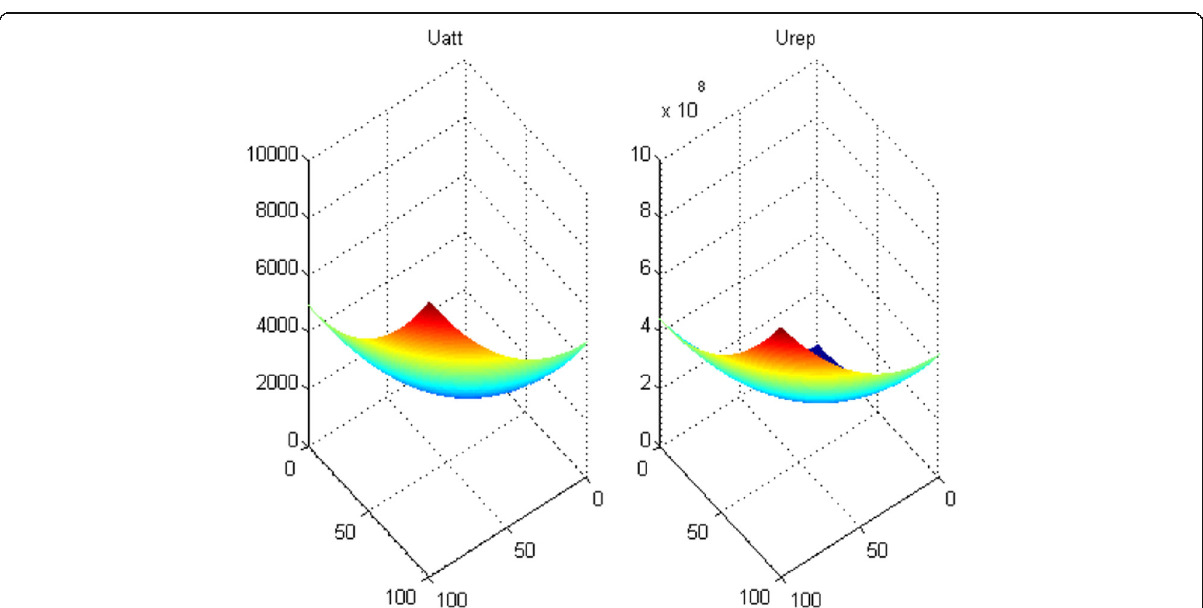
Fig. 10 Mesh plot of the potential energy of attraction and repulsion in the artificial potential field algorithm for circular obstacles with radius R